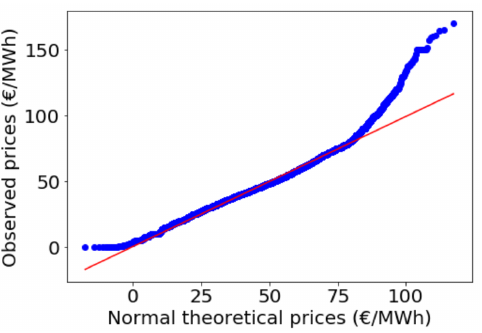
Figure 6. Probability plot of electricity price versus normal distribution.